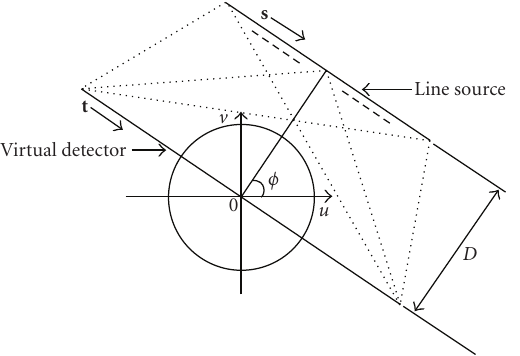
Figure 1: Line x-ray source acquisition